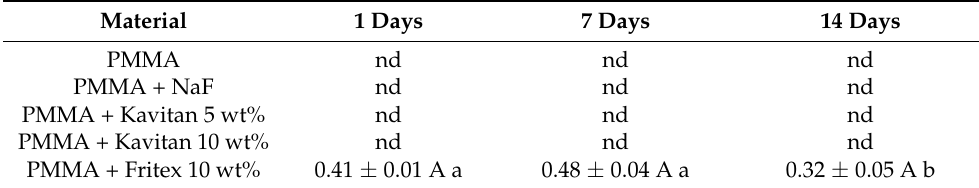
Figure 3. Amount of fluoride released after contact with the 1450 ppm fluoride toothpaste. Table 3. Mean values ± SD of fluoride release [µg/cm 2 ].